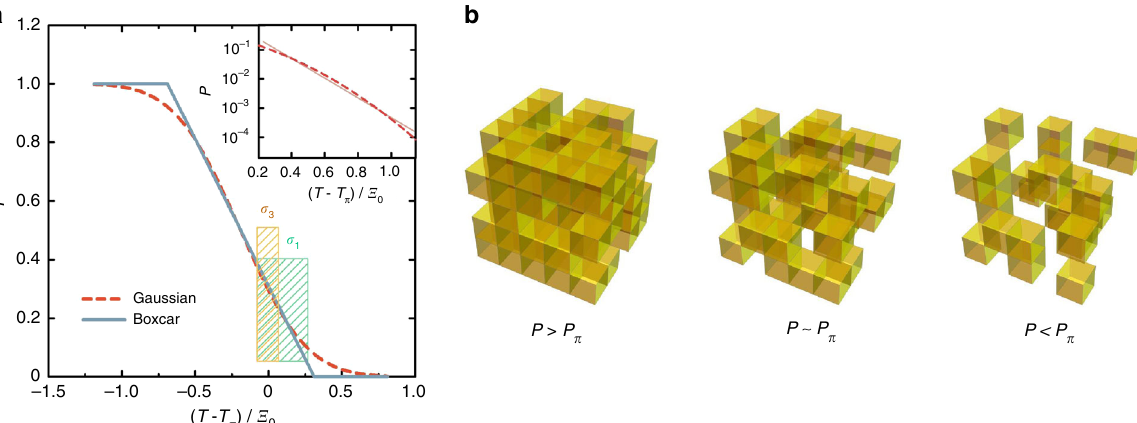
Fig. 2 The superconducting percolation model. a Comparison of two different assumptions for the dependence of the superconducting volume fraction P on temperature, for 3D site percolation. The solid line is the linear assumption — equivalent to a boxcar distribution of local gaps — and the dashed line is obtained if a Gaussian local gap distribution is assumed. The widths of the distributions are taken to be the same and equal to Ξ 0 . The shaded areas indicate the temperature ranges in which linear and nonlinear conductivity are appreciable in the experiment; this demonstrates that the linear assumption is justi fi ed in our case. The inset shows the tail of the integrated Gaussian distribution (dashed line) compared to a pure exponential decay (solid line) on a log-linear scale. The difference is relatively small across four orders of magnitude. Other distributions result in an exact exponential tail, e.g., the gamma and logistic distributions are asymptotically exponential. b Schematic representation of the superconducting site-percolation model in a cubic geometry. Yellow patches are superconducting. Above the critical concentration P π (below T π ), a sample-spanning superconducting cluster